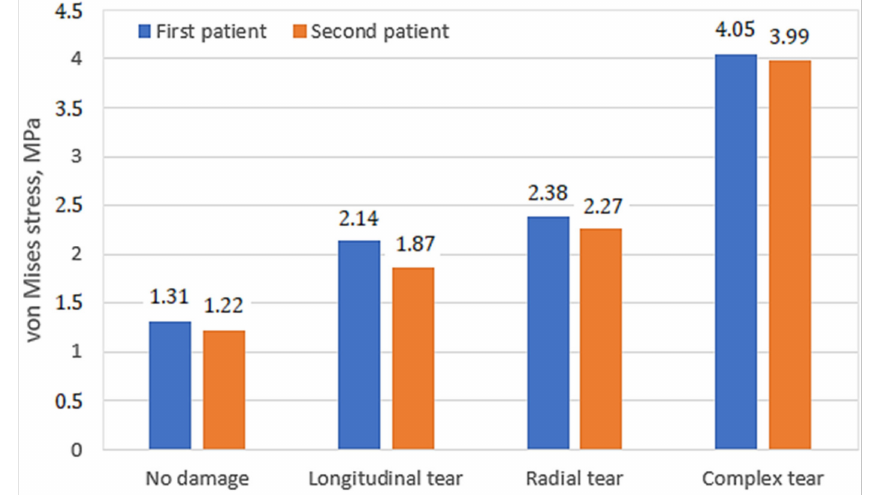
Figure 8. Maximum von Mises stress values on femur